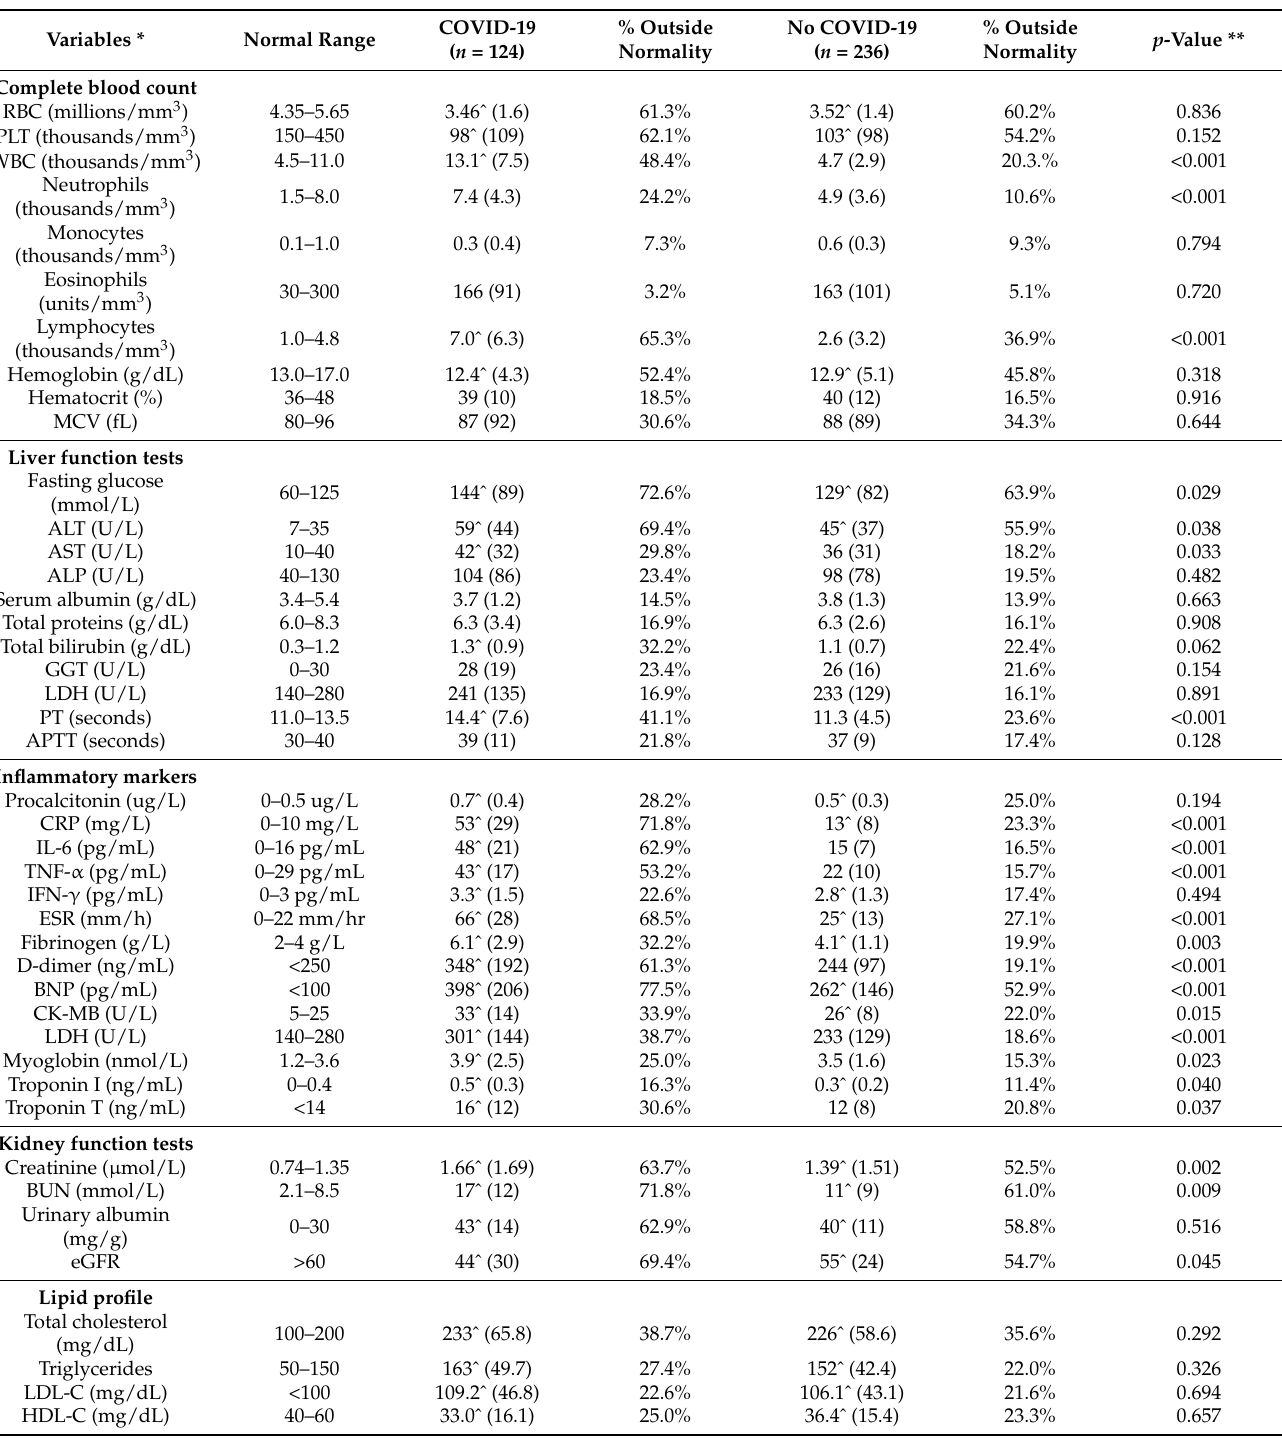
Table 2. Biological profile comparison between heart failure patients stratified by SARS-CoV-2 infection